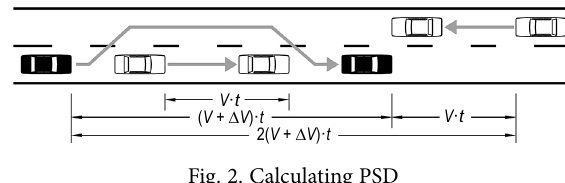
Fig. 2. Calculating PSD